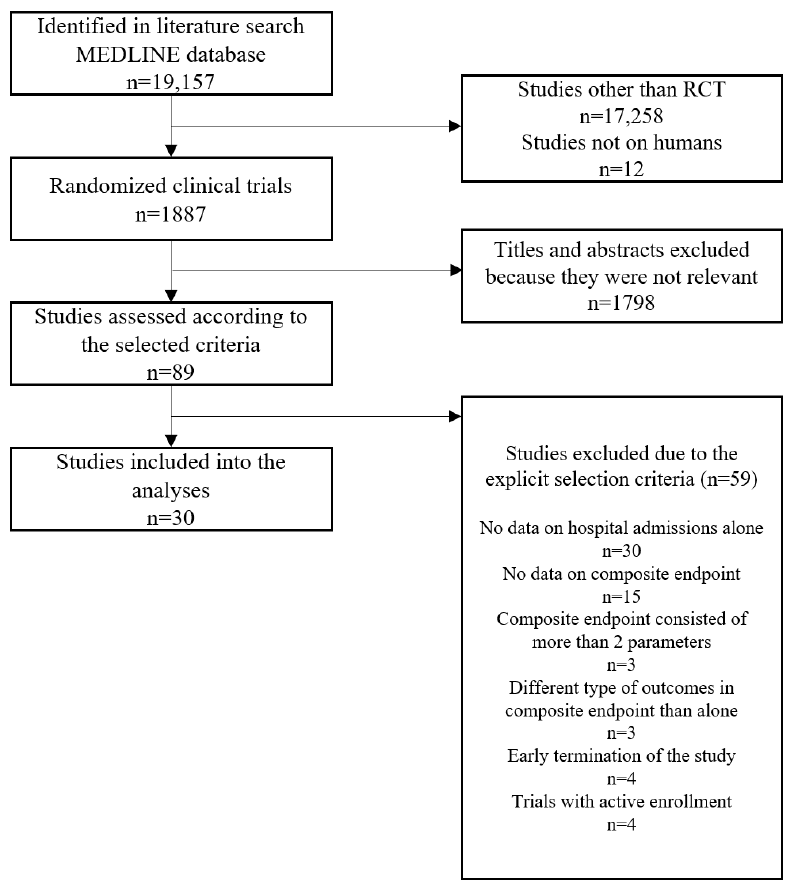
Figure 1 . The summary of the evidence search and selection — flowchart. RCT – randomized clinical Figure 1. The summary of the evidence search and selection—flowchart. RCT–randomized clinical trial. trial.